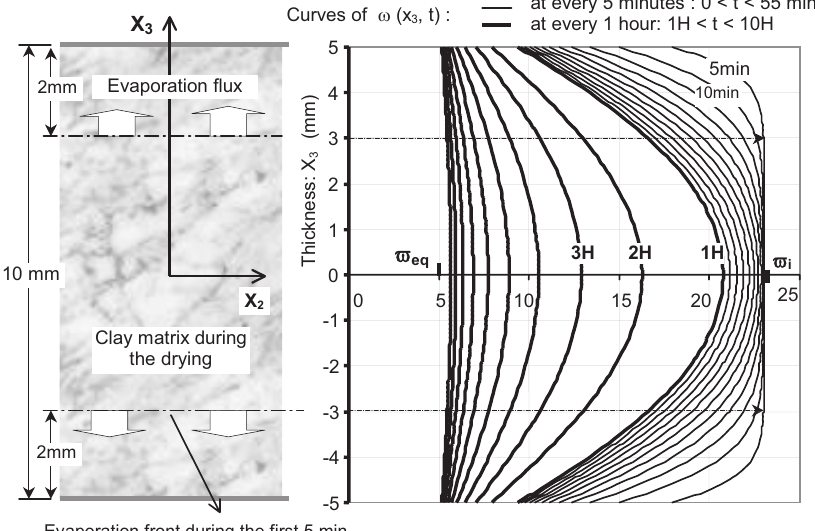
Fig. 9. Simulation of a flat clay matrix drying (case of the red clay of Gu´erin-Kouka): evolution of the water content at every 5 min and at every 1 h.